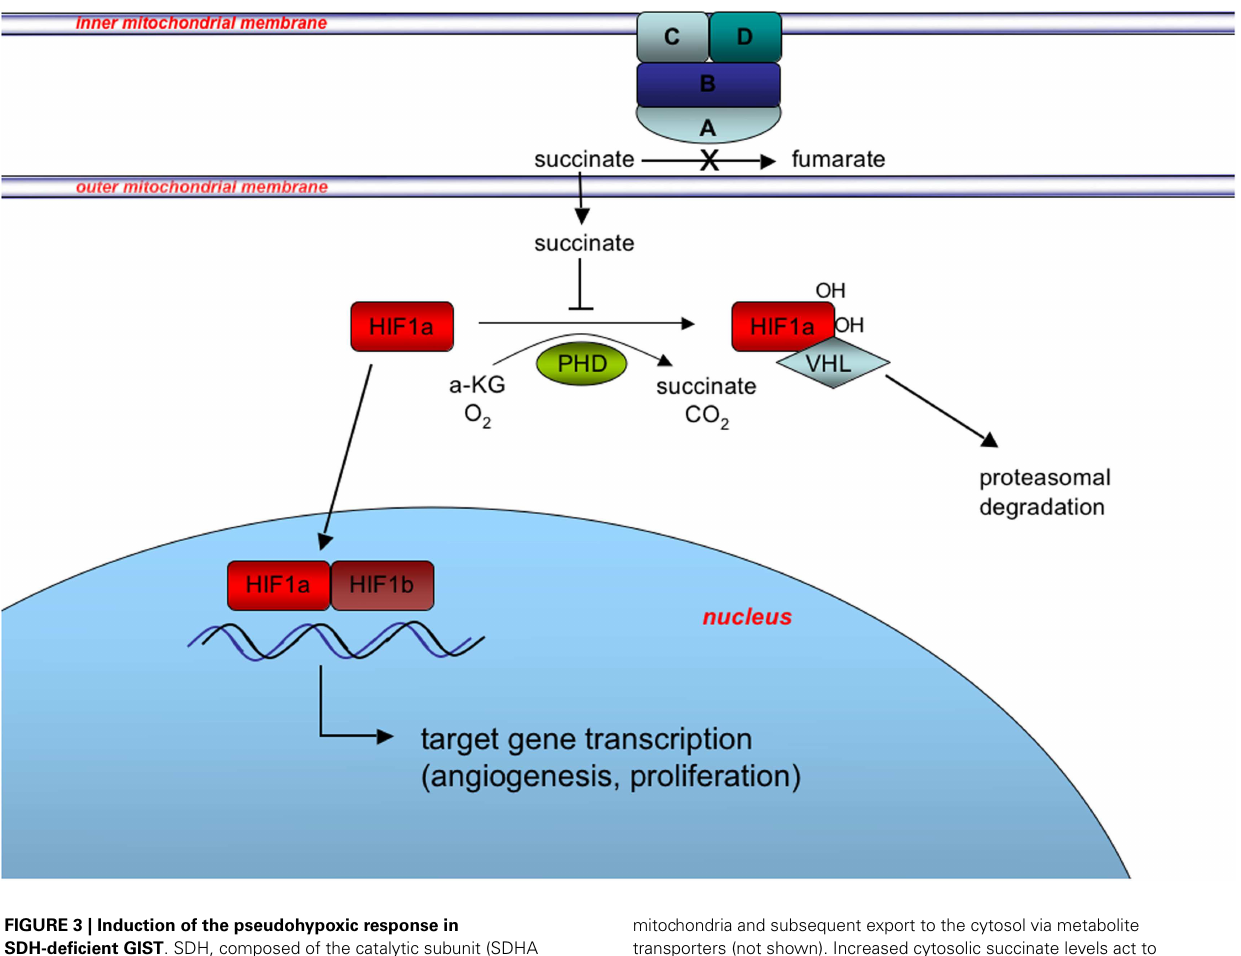
mitochondria and subsequent export to the cytosol via metabolite transporters (not shown). Increased cytosolic succinate levels act to stabilize one of three HIF α subunits (HIF1 α is shown for simplicity) via product inhibition of PHD-mediated hydroxylation of HIF1 α , which skirts theVHL-mediated targeting of HIF1 α for degradation. Stabilization and nuclear translocation of HIF1 α leads to formation of the heterodimeric HIF transcription factor with constitutively expressed nuclear-located HIF1 β , and induction of the pseudohypoxic